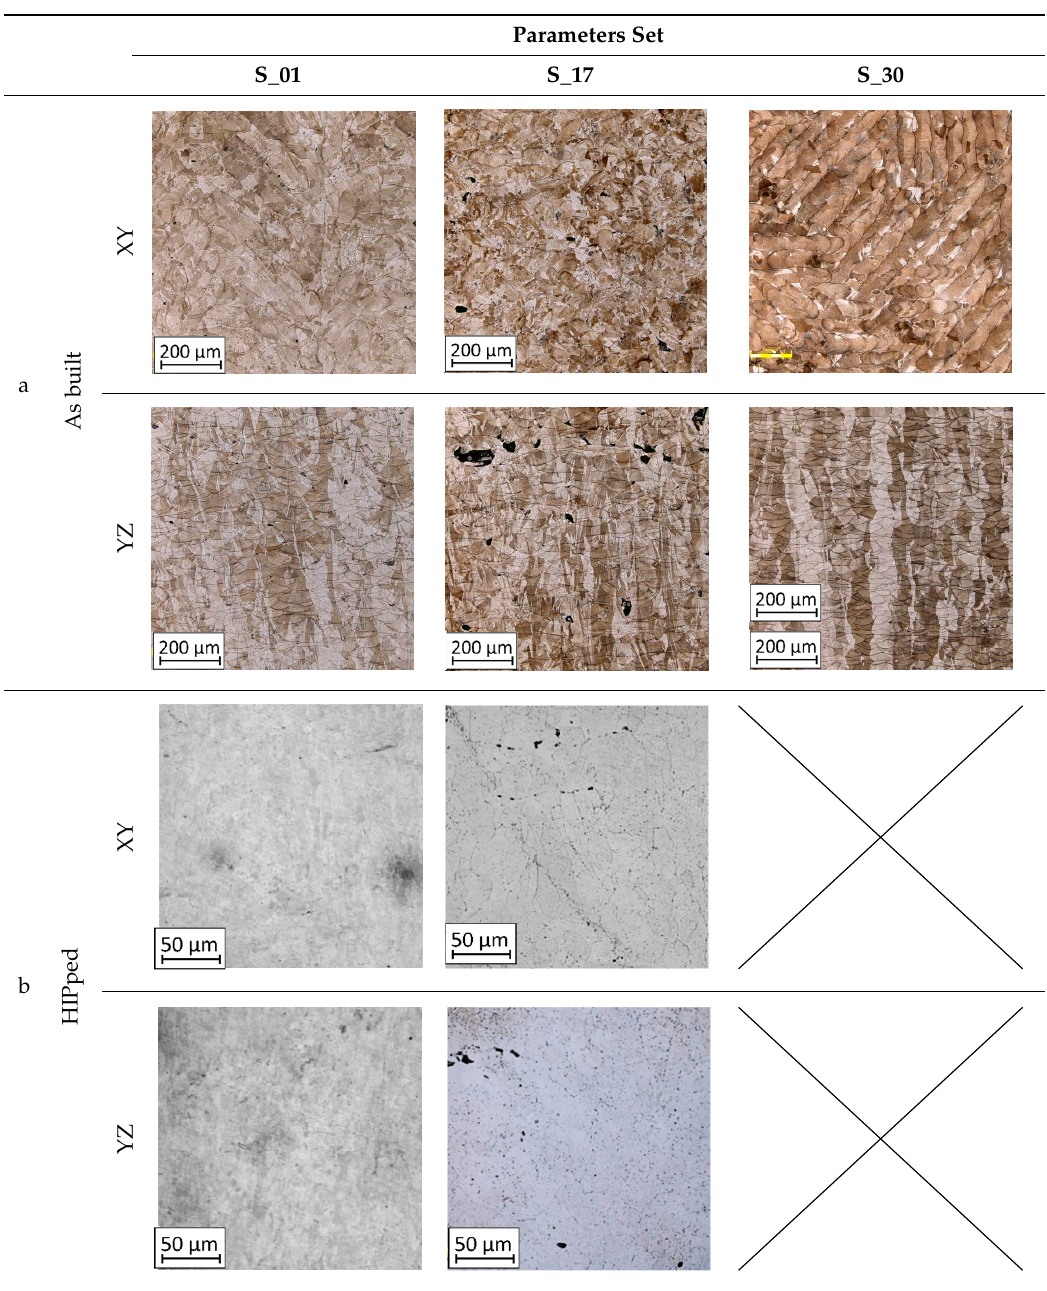
Table 4. Microstructure of S_01; S_17 and S_30 samples heat treated using different processes and their combinations.